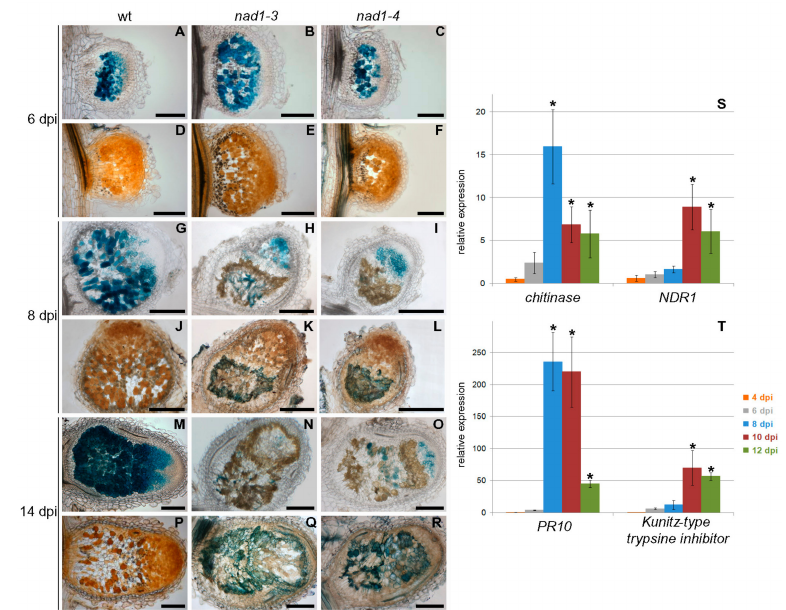
Figure 5. ( A – T ) Defense responses are activated in nad1-3 and nad1-4 nodules between 6 and 8 dpi with S. medicae WSM419 carrying the GUS reporter gene. ( A – R ) The brown pigmentation in nad1 nodules corresponds to accumulation of phenolic compounds. Nodule sections of wild-type (first column) and nad1-3 (second column) and nad1-4 (third column) mutants were stained for the activity of β -glucuronidase ( A – C , G – I , M – O ) to detect the presence of bacteria and with potassium permanganate and methylene blue dye ( D – F , J – L , P – R ) to visualize phenolic compounds in blue at 6 ( A – F ), 8 ( G – L ) and 14 dpi ( M – R ). Wild-type and mutant nodules are colonized equally and no accumulation of polyphenolics was detected 6 dpi ( A - F ). The brown pigmentation appeared in nad1 nodules at 8 dpi ( H , I ) overlaps with the region containing polyphenols ( K , L ), indicating the activation of defense responses in mutant nodules. The accumulation of polyphenolic compounds expanded in increased area of the mutant nodules at 14 dpi ( N , O , Q , R ) but brown pigmentation was not detected in wild-type nodules at any time points. Scale bars: ( A – R ) 200 µ m. Temporal induction of defense-related genes (a chitinase , NDR1 , PR10, and a Kunitz-type trypsin inhibitor ) in nad1 nodules analyzed with quantitative RT-PCR following S. medicae WSM419 inoculation. Relative transcript levels at different time points were calculated in relation to wild-type plants ( S , T ). Error bars indicate ± SE. * p ≤